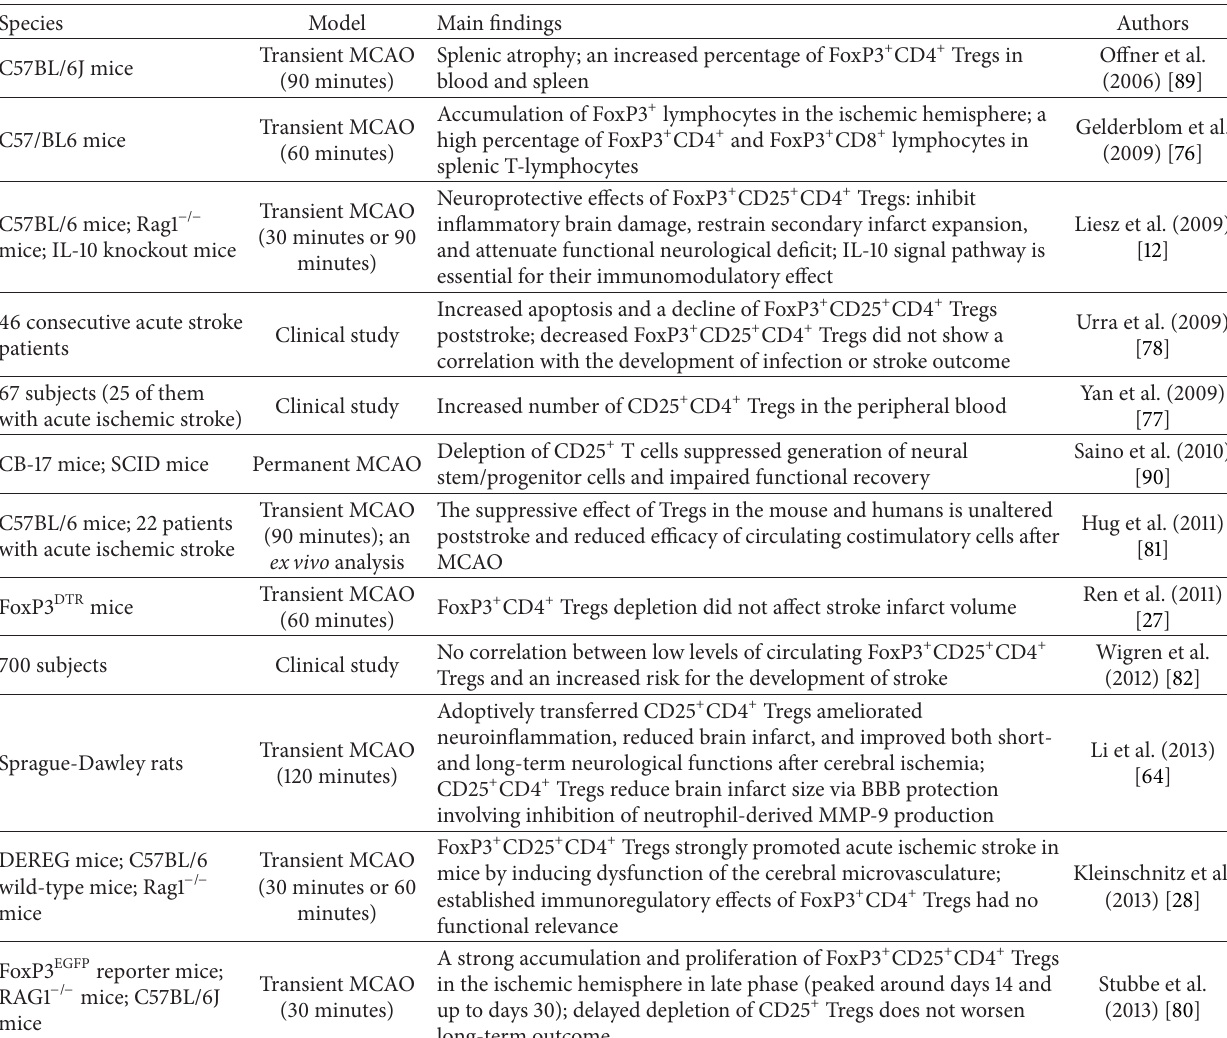
Table 1: Main findings of FoxP3 + CD25 + CD4 + Tregs in the pathogenesis of